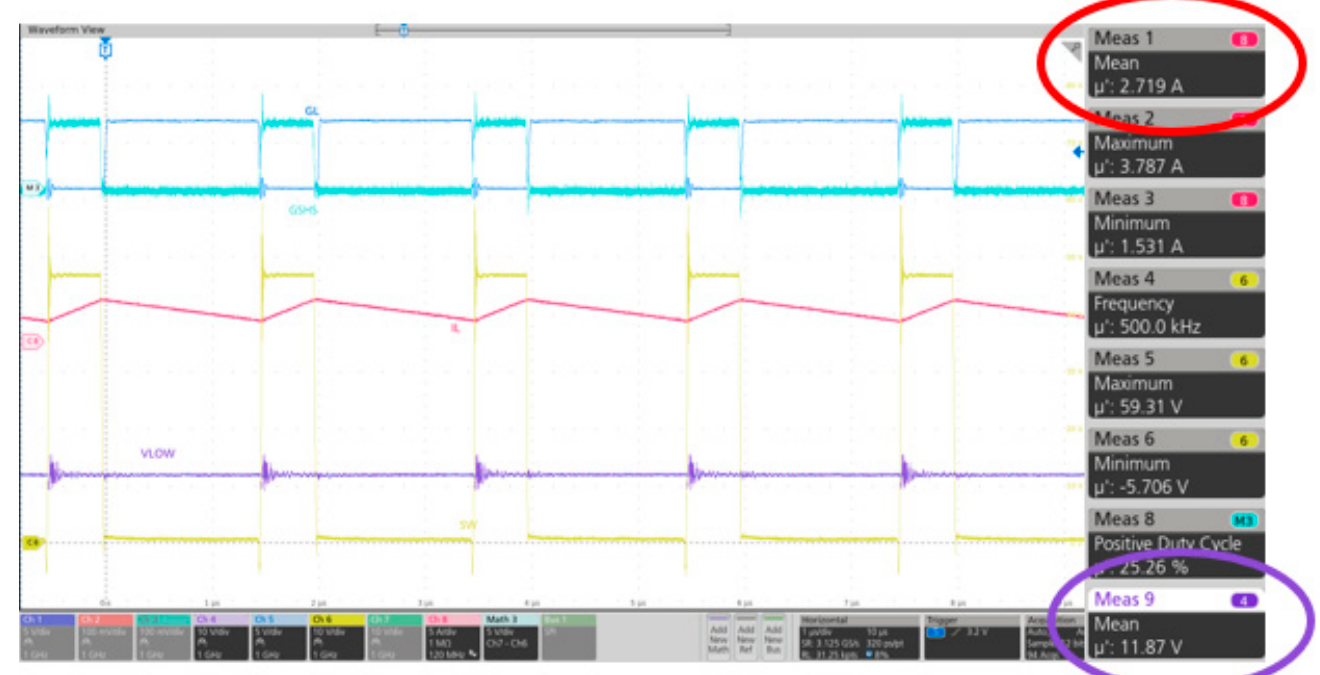
Figure 16. Dynamic current regulation in buck mode operation from 0 A to 8 A. Red line for I OUT (20 A/div) and yellow line for V DS low side (10 V/div).